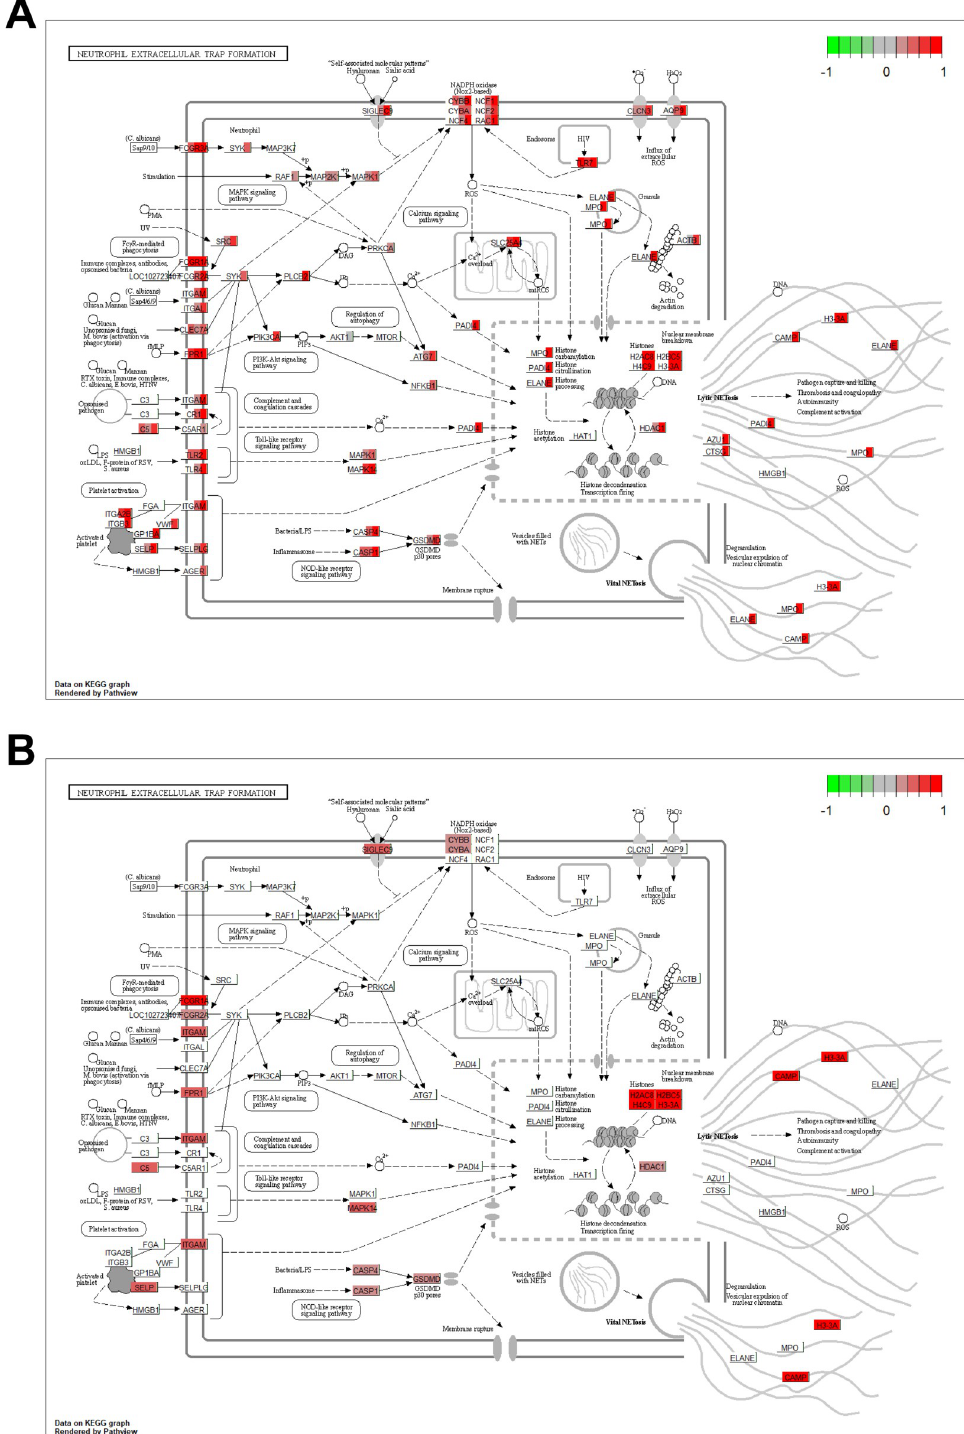
Fig 3. KEGG NET formation pathway illustrating the fold changes (log2) for significantly upregulated genes at different time points. A) Gene expression as fold-change is indicated by a color block in the background rectangle or each gene corresponding to the contrasts, 13–18, 7–12, 1–6 months before diagnosis and TB compared to their respective controls (from left to right). B) As above but illustrating the significantly increased expression of genes in TB patients with high PET-scores compared to those with low PET-scores. Figures rendered by the R Bioconductor pathview package [29], on finite resolution raster images from KEGG. https://doi.org/10.1371/journal.pone.0278295.g003 PLOS ONE | https://doi.org/10.1371/journal.pone.0278295 December1,